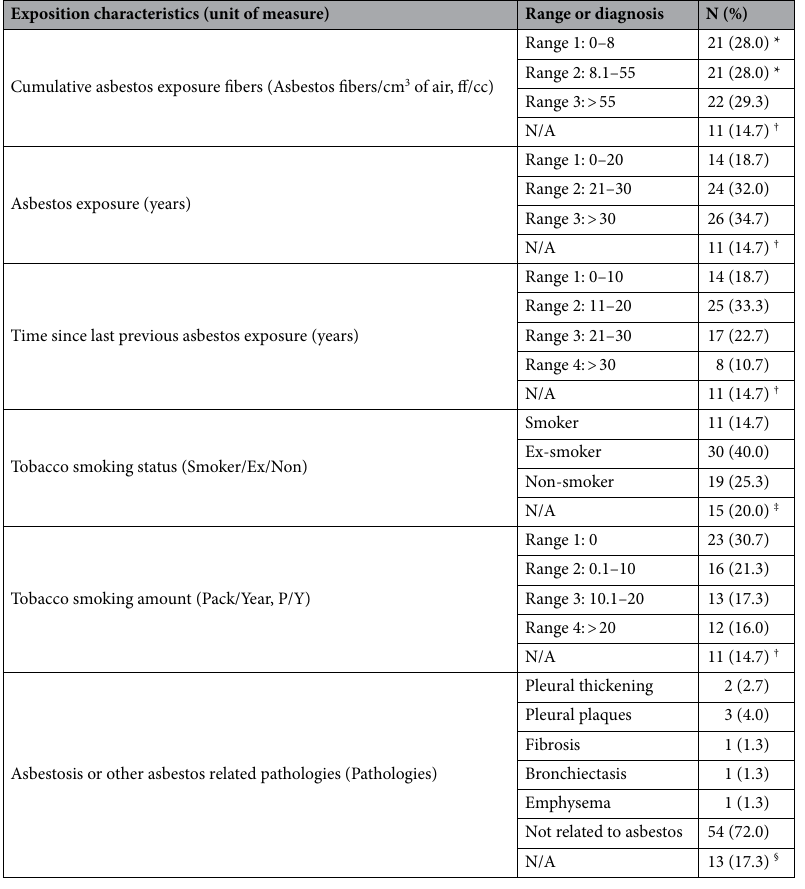
Table 1. Exposition data of the WEA cohort. *p < 0.05 compared to Range 3. † Data available for 64 out